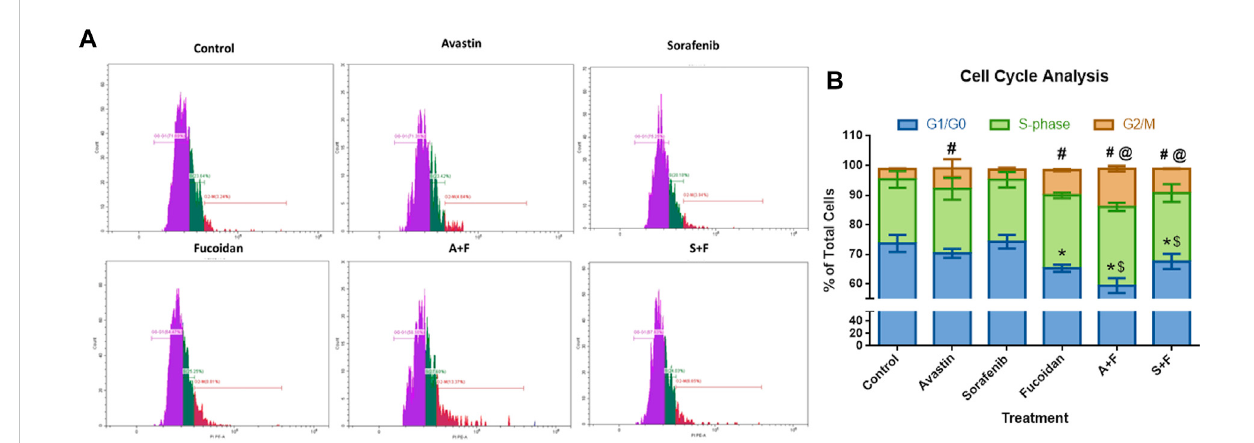
FIGURE 5 CellcycleanalysisshowingtheeffectofAvastin,sorafenibandfucoidanasmonotherapiesorincombinationonthecellcycleprogressionofHUH-7 cells. (A) Representative histograms showing the cell population distribution in each cell cycle phase after the various treatments. (B) Stacked bar chart showingthe%oftotalcellsdetectedinG0/G1,S-PhaseandG2/Mphases.Nosigni fi cantdifferencesbetweentheuntreatedcontrolandsorafenibtreated cells were observed with around 74% of the cells in the G0/G1 phase, 21% in S-phase and 3.5% in the G2/M phase. Avastin treated cells signi fi cantly had higher portion of cells arrested in the G2/M phase compared to the untreated control (7% versus 3.5%) while 70.4 % and 21.7% of the cells were detectedintheG0/G1andS-phases, respectively. Infucoidan,A+FandS+Ftreatedcells, adifferentpatternwasobserved, withmorecellsarrestedinthe S-phase and G2/M phases compared to the untreated control. This pattern appears to be induced by fucoidan as both A+F and S+F had a signi fi cantly higher percentage of cells in the S-phase (26.6% and 23.1%, respectively) and G2/M phase (12.9% and 8.2%, respectively) versus the monotherapies. G0/ G1: * p ≤ 0.01 versus untreated control and $ p < 0.05 compared to monotherapy; G2/M: # p < 0.05 versus untreated control and @ p < 0.05 compared to monotherapy, One-way ANOVA, Tukey ’ s Post-Hoc.